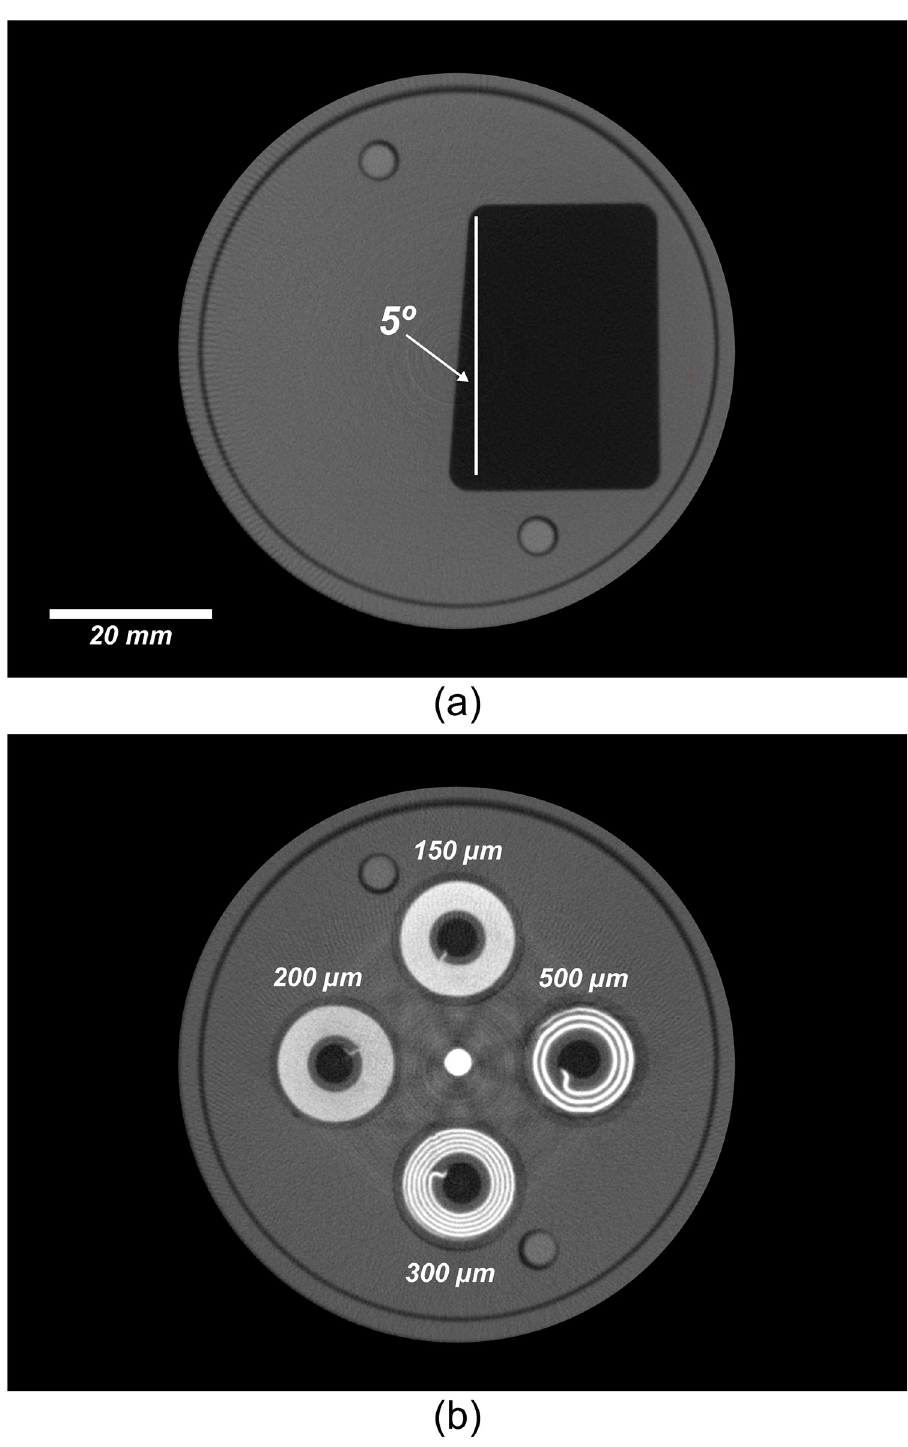
Fig 9. Evaluation of spatial resolution of the cost-efficient CT scanner. (a) a single reconstructed transaxial-slice CT image of the slanted-edge plate of the CT quality assurance phantom. (b) reconstructed transaxial-slice CT image of the resolution coil plate of the CT quality assurance phantom illustrating the qualitative display of resolution coils.